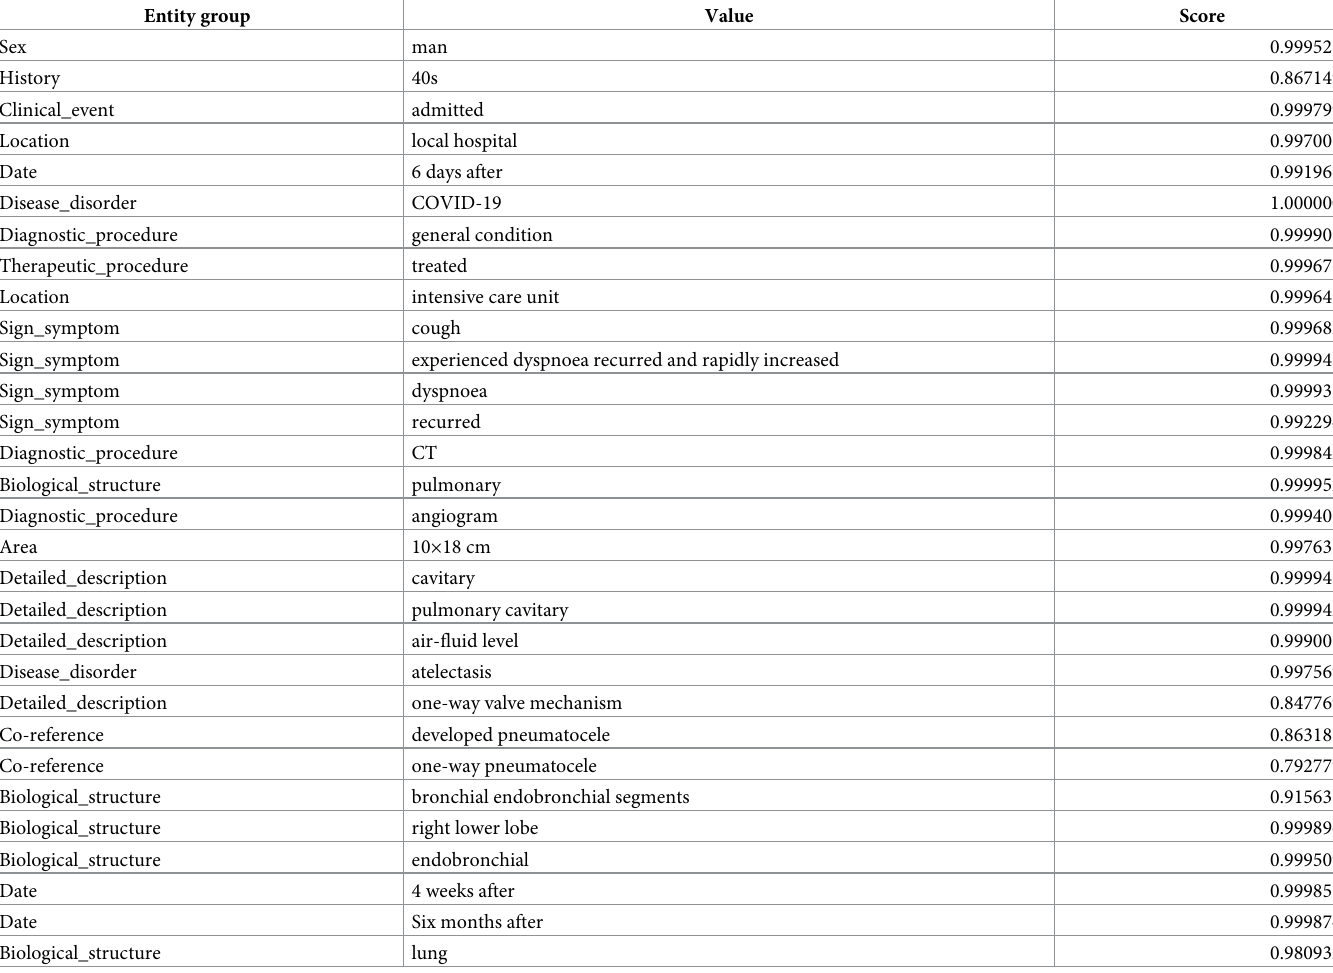
Table 5. The confidence score of the model on different named entities by BioEN.